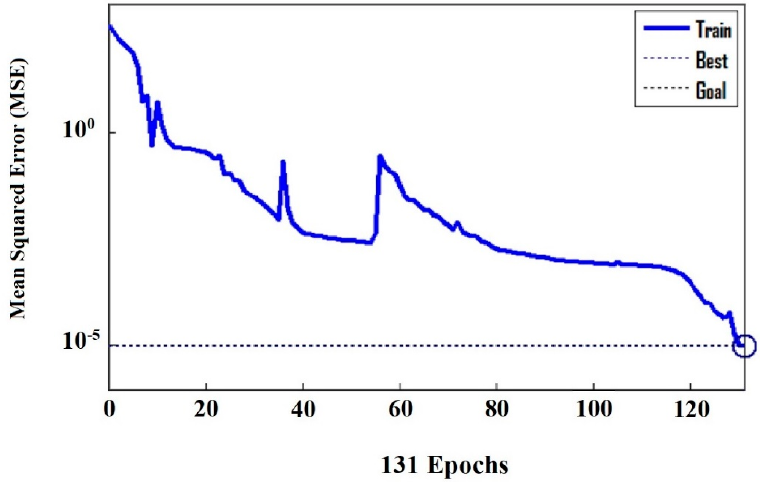
Figure 12. Evolution of training and test errors as a function of the number of training (epochs) of Sn-Zn-Cu alloys using ANN model.